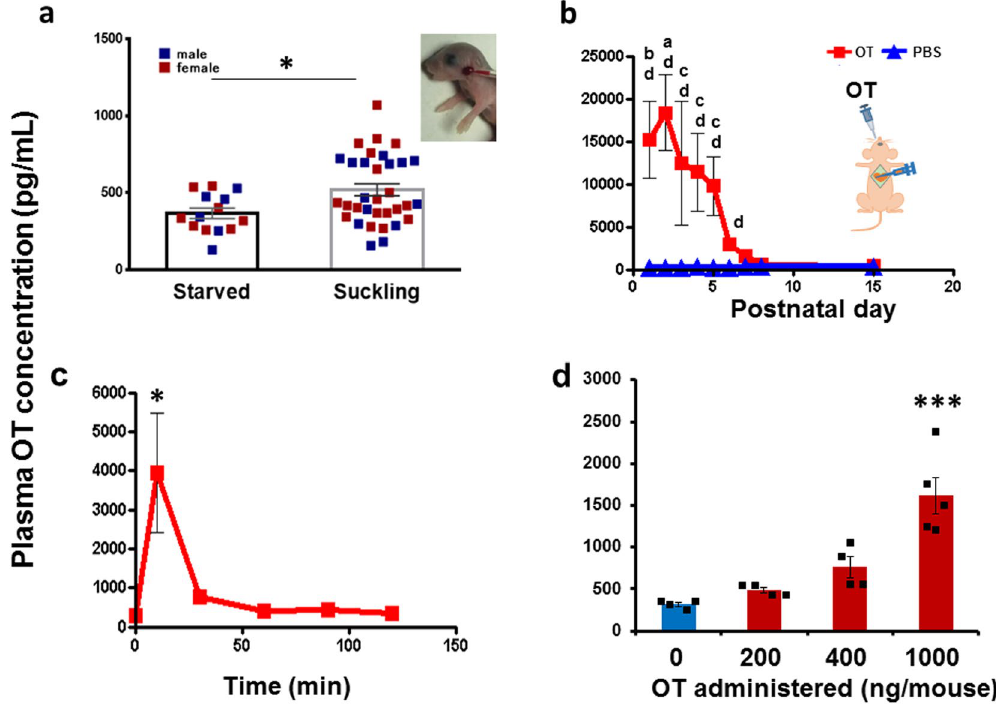
Figure 1. Plasma oxytocin (OT) concentrations in wild-type (C57BL/6) mice. ( a ) Plasma OT levels in PND1 male and female pups after fasting for 20 min and with or without feeding with dam’s milk for 20 min. N = 14 and 33 mice. * P < 0.05, two-tailed Student’s t -test. Inset shows blood collection from the facial vein. ( b ) Time course of plasma OT levels in pups 10 min after oral administration of OT (squares; 1 μ g of OT/mouse; 10 μ L of 100 μ M OT) or PBS (triangles; 10 μ L). Experiments were carried out on the indicated postnatal days. The number of mice was 3–15 for OT and 3 for saline. A two-way ANOVA revealed a significant difference between the drug treatment and saline treatment, F 8,90 = 3.32, P < 0.002. Bonferroni’s post hoc tests showed a P < 0.001, b P < 0.01 and c P < 0.05 from the value at PND8; d P < 0.01 for the saline group. Inset shows the scheme of OT administration to the mice and blood collection from the heart after opening the chest. ( c ) Time course of plasma OT levels of PND6 pups measured at the indicated times after oral administration of 1 μ g of OT/mouse, N = 4–5 mice. One-way ANOVA, F 5,37 = 3.302, P < 0.0001; * P < 0.02 from the control value. ( d ) Plasma OT concentrations in PND6 pups after 10 min of oral administration of OT at the indicated concentrations. N = 3 mice. One-way ANOVA, F 3,24 = 20.4, P < 0.0001. Bonferroni’s post hoc tests showed *** P < 0.001 from other